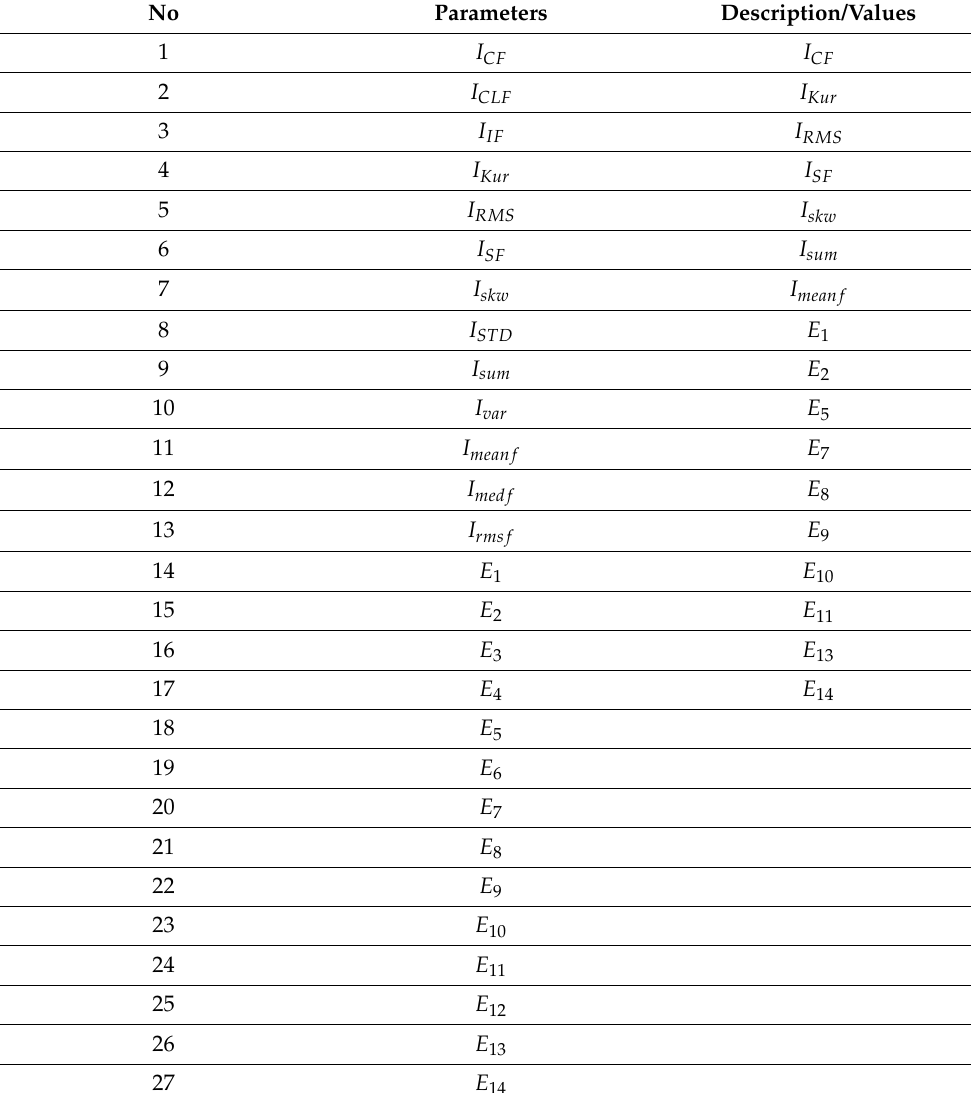
Table 3. All extracted features and features.